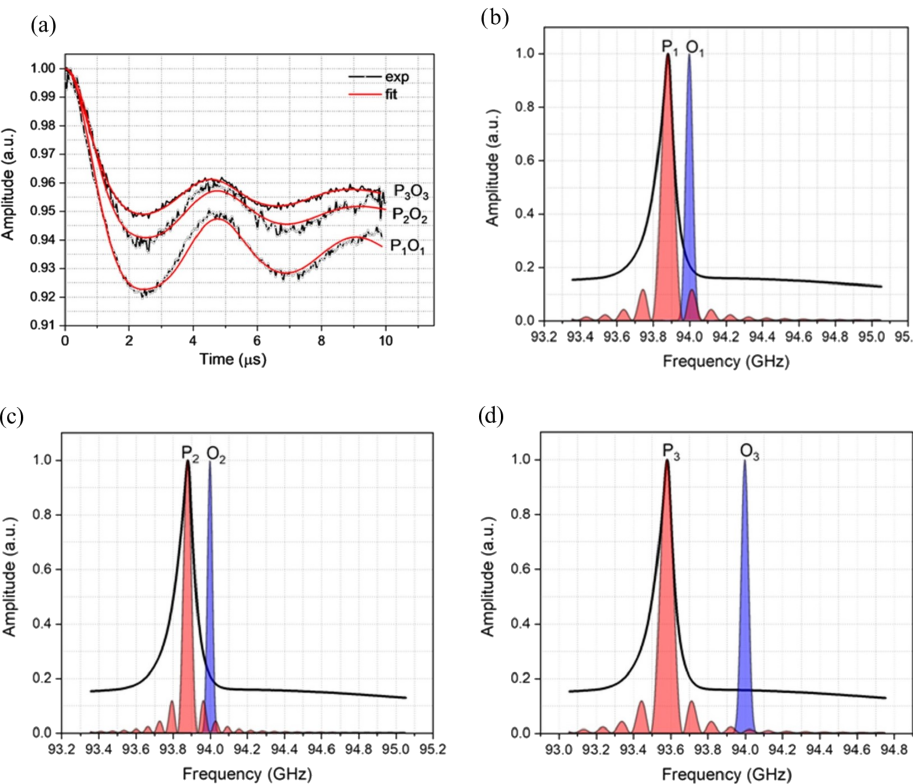
Figure 3. (a) Background-corrected DEER data (black curves) of Gd ruler (6.0nm) recorded with different PO offsets with the fits (red) obtained by DeerAnalysis (2019) (Jeschke et al., 2006). Excitation profiles of the pump (P) and observer (O) at different frequency offsets,